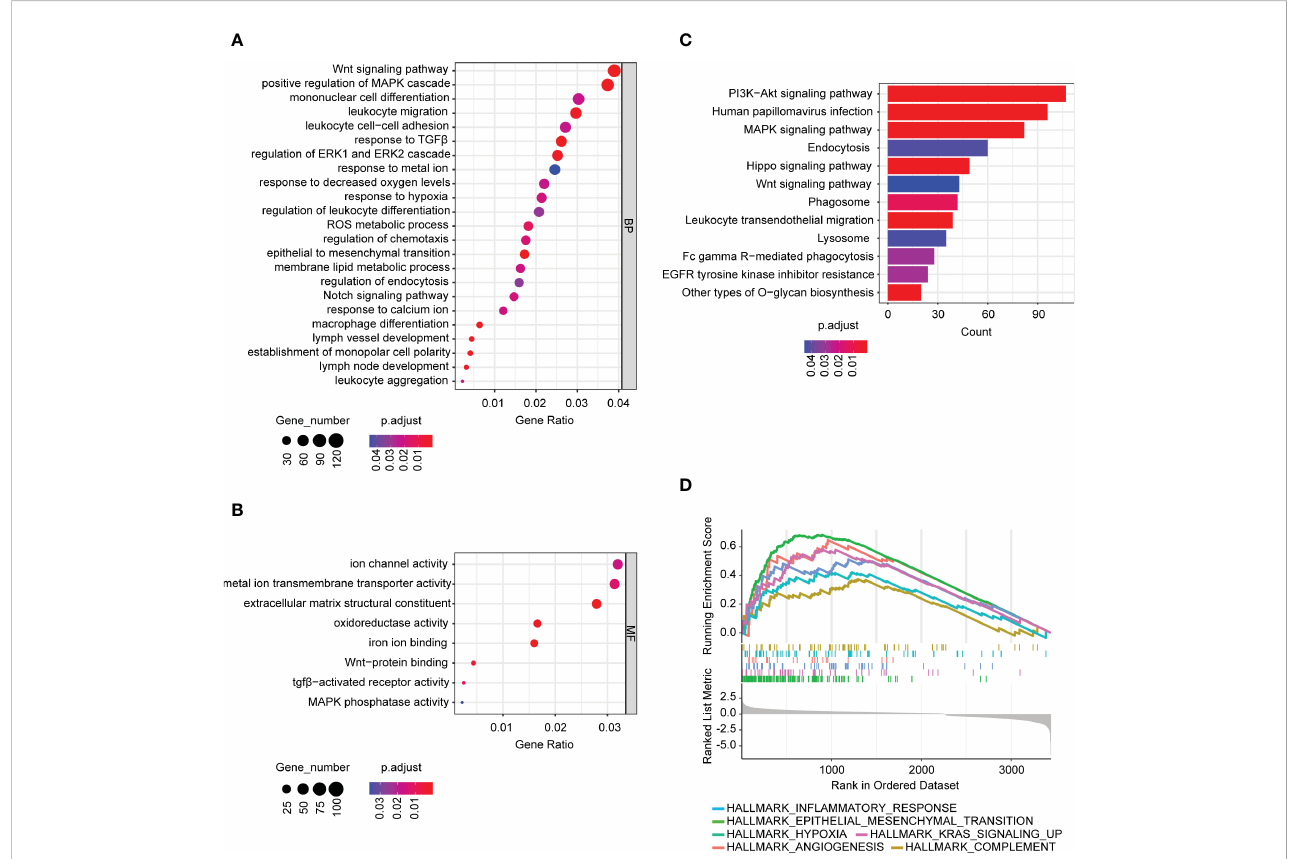
FIGURE 4 The signaling pathways associated with BASP1 expressions. (A, B) Bubble plot of GO analysis of differentially expressed genes between BASP1 high and BASP1 low group, including biological processes (A) and molecular functions (B) . (C, D) KEGG (C) and GSEA (D) analysis of differentially expressed genes between BASP1 high and BASP1 low